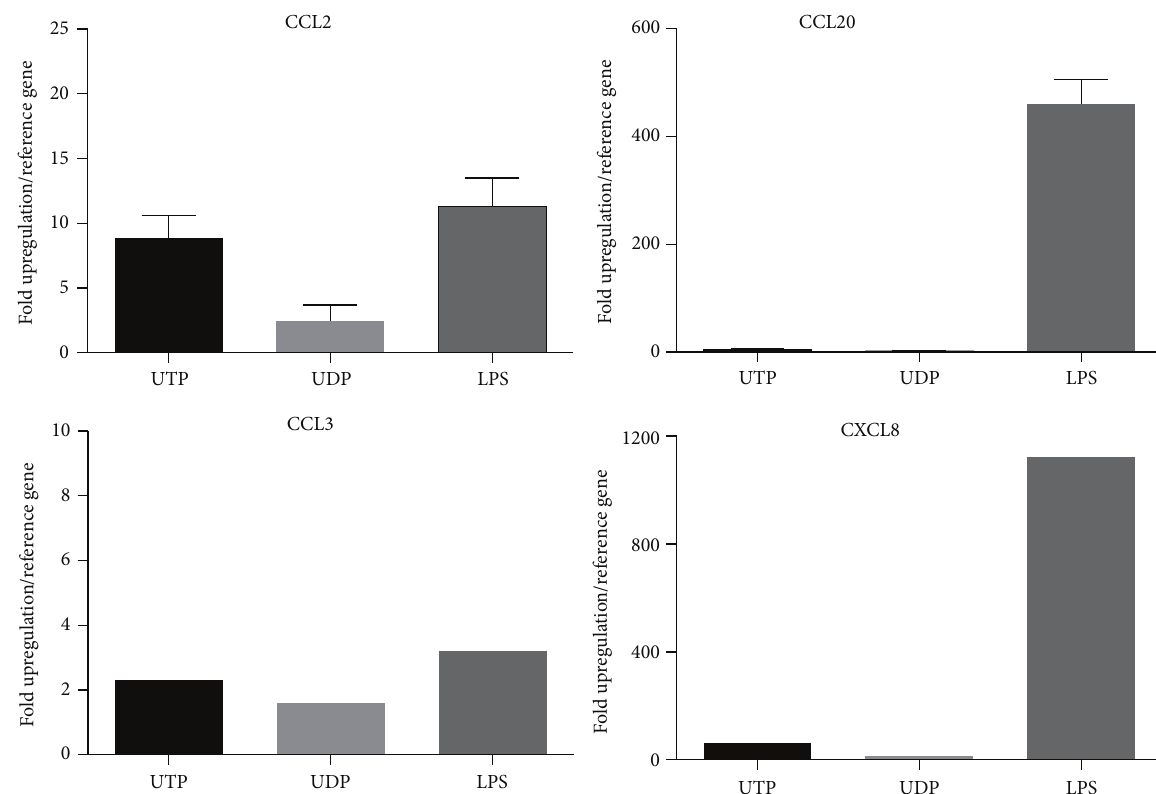
Figure 4: UTP induces CCL2 gene transcription in THP-1 monocytes. THP-1 cells were plated in RPMI media containing 1% serum and stimulated with media alone, LPS (1 𝜇 g/mL), UTP (10 𝜇 M), or UDP (10 𝜇 M) for 2 hours. RNA was extracted, reverse transcribed to cDNA, and probed with quantitative PCR primers for chemokines (CCL2, CCL20, CCL3, and CXCL8) and reference genes ( 𝛽 -actin and GAPDH). PCR was performed in triplicate using a Rotorgene 2000. Data was analysed using the 2 −ΔΔ Ct method using a threshold of